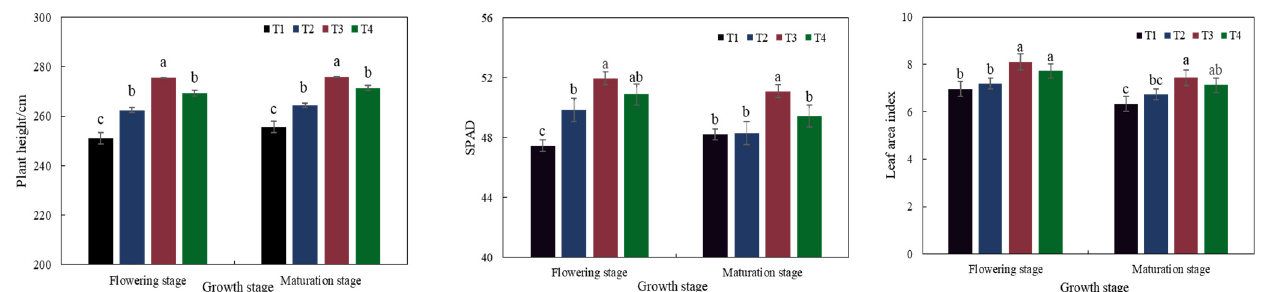
Figure 3. Effects of different irrigation quotas on plant height, SPAD, and leaf area index of maize. Note: Different lowercase letters indicate that there are significant differences between different treatments of each index in the same growth period.